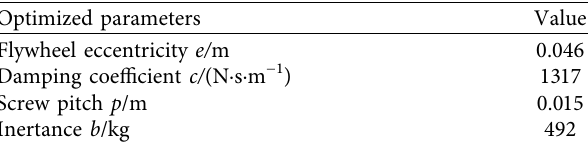
Table 2: Optimal parameters of suspensions with series-connected eccentric inerters.